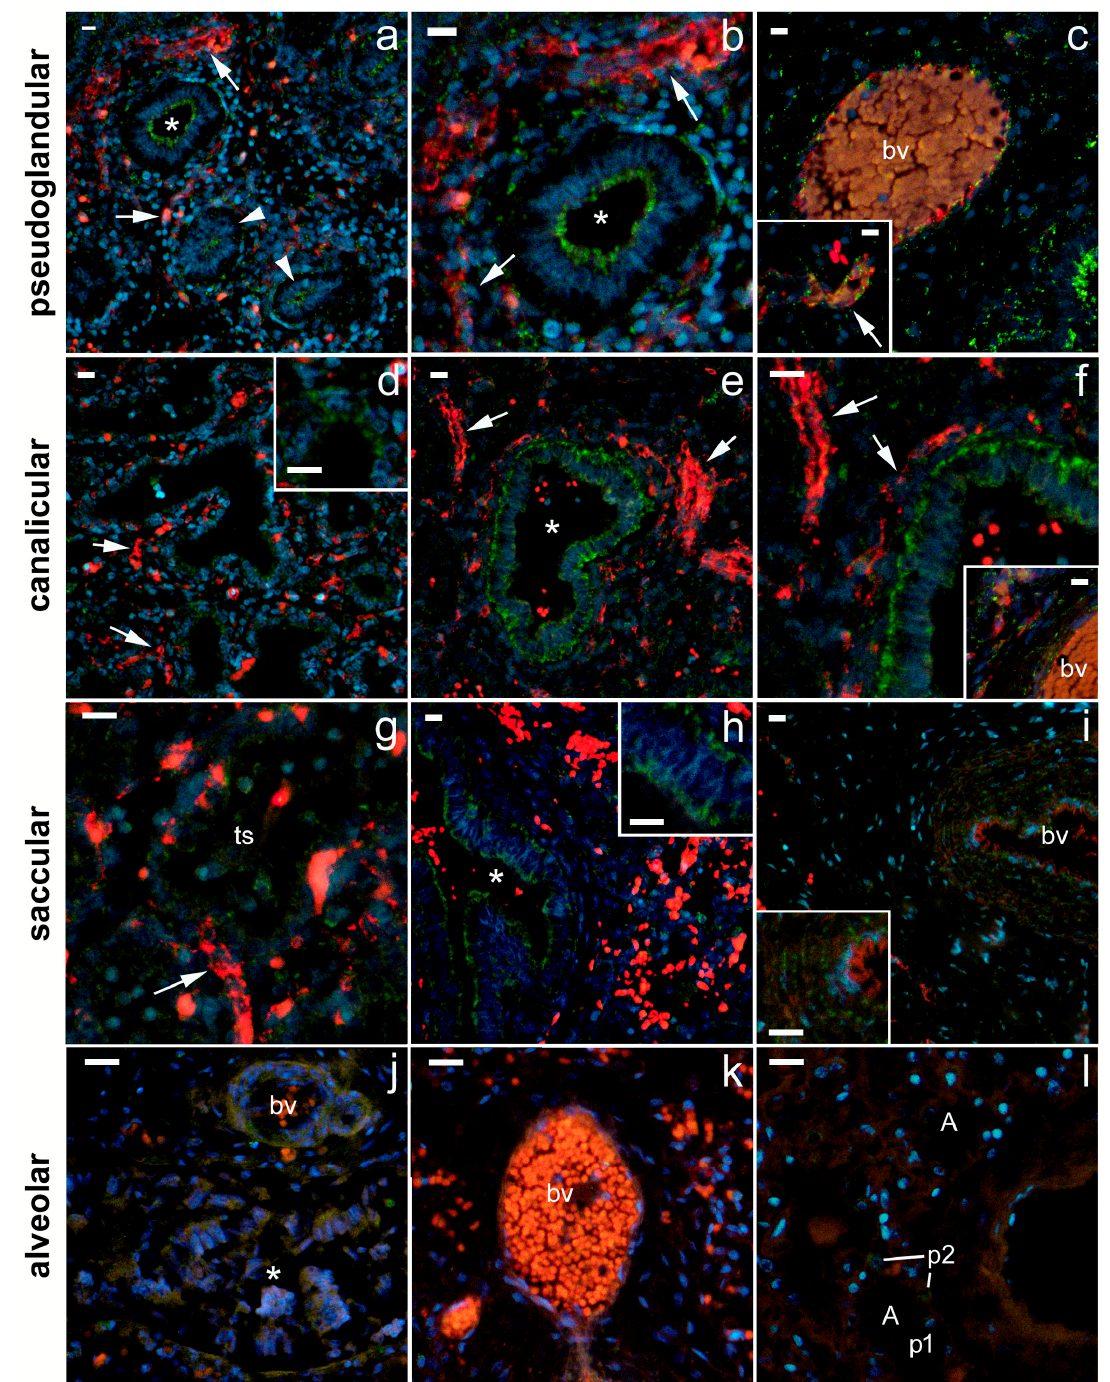
Figure 4. Immunofluorescence staining of fetal human lungs in different developmental stages: pseu- doglandular ( a – c ), canalicular ( d – f ), saccular ( g – i ), and alveolar ( j – l ) with 5-HT1A and CD31/PECAM markers. Nuclear DNA 6-diamidino-2-phenylindole dihydrochloride (DAPI) staining (blue) merged with 5-HT2A receptor (green) and CD31/PECAM (red) immunofluorescence is shown in parallel (merge). Pictures were captured at 400 × magnification; ( a , c , d ) (main figure), ( e , h ) (main figure), and ( i ) (main figure)— downsized. Scale bars = 20 µ m. Asterisk—proximal airways/bronchioli; arrows—blood capillaries; arrowheads—distal airways, cuboidal epithelium lining the airspaces; bv—blood vessel (mostly artery); smc—smooth muscle cells; ts—terminal sacs;